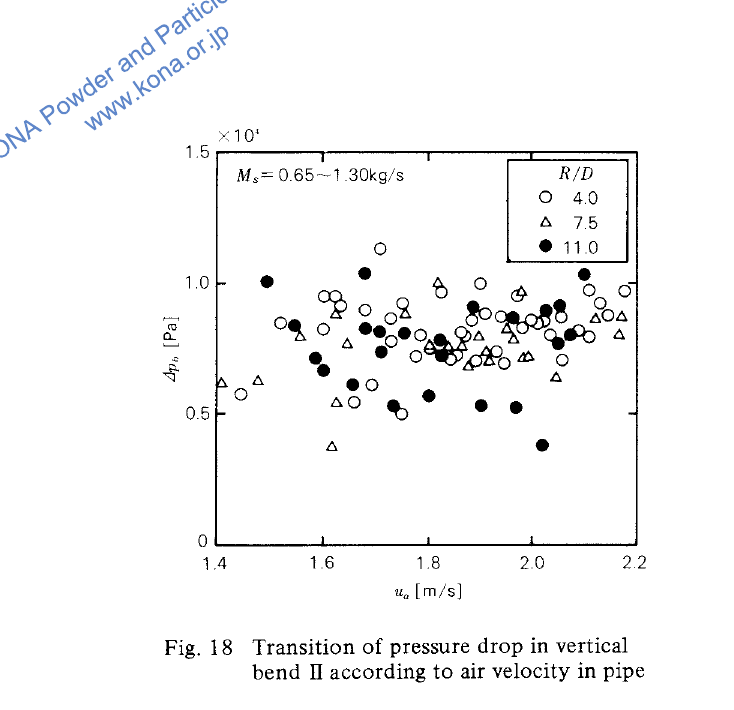
Fig. 18 Transition of pressure drop in vertical bend II according to air velocity in pipe